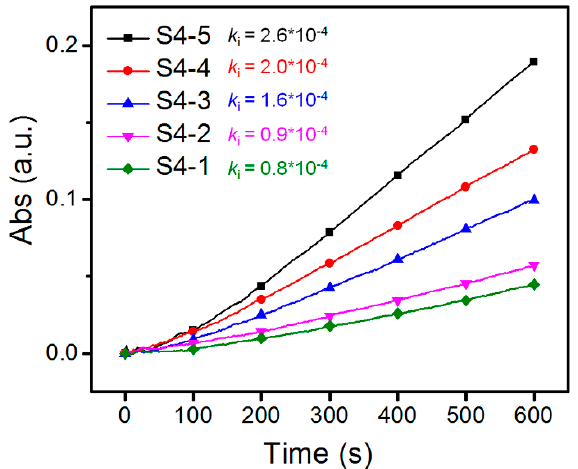
Figure 4. Time course of turbidity towards the binding behavior between Con A and HPManEMA- co -MBA ( DB = 30.6% ) at 25 °C. The concentration of Con A was 1 μ M, and the concentration of ManEMA unit was adjusted to be 500 μ M for each sample.